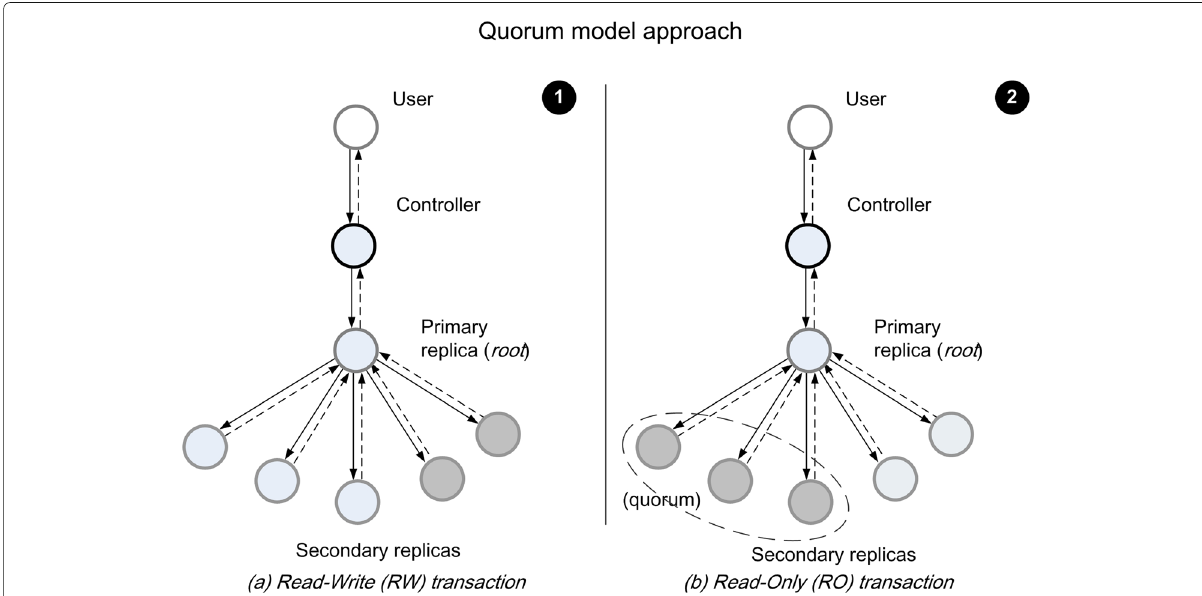
Fig.2 Standard approachfor consistency management - an example of the execution of read and write operations withinthe Quorum approach[13]